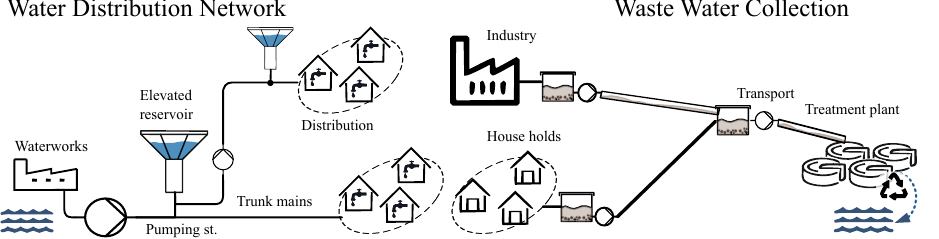
Figure 2. Sketches of two water infrastructures: ( Left ) A water distribution network. ( Right ) A wastewater transport